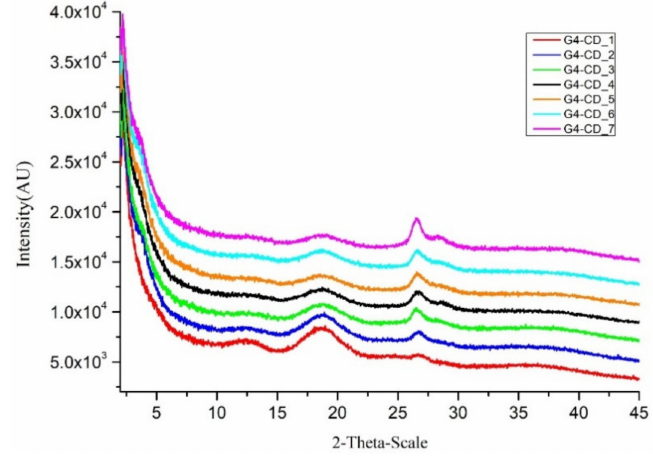
Figure 4. Powder X–ray diffraction patterns of freeze–dried G4–CD_1–7.